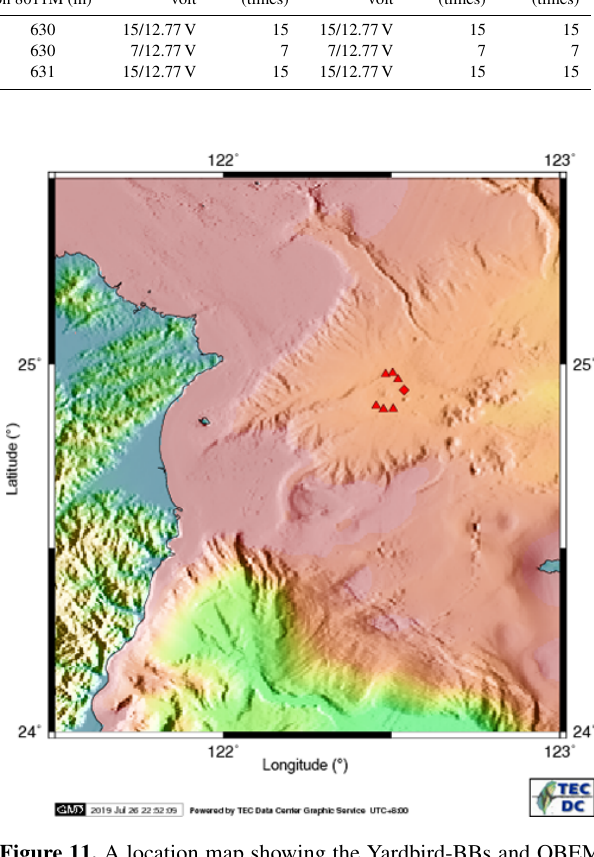
Figure 11. A location map showing the Yardbird-BBs and OBEM with triangle and diamond symbols,